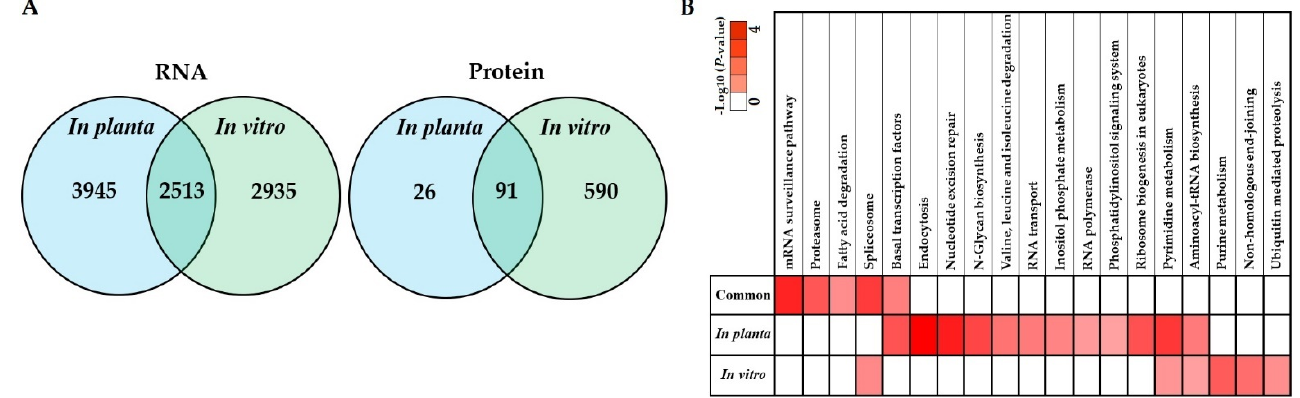
Figure S1: Correlation between RNA-seq and qPCR, Figure S2: Comparison of differently abundant transcripts from S. subterranea in resistant and susceptible potato cultivars, Table S1: List of primers used in this study, Table S2: RNA-seq information, Table S3: List of identified, annotated and differentially expressed transcripts, Table S4: List of identified and differentially expressed proteins, Table S5: List of common proteins in both RNA-seq and proteomics, Table S6: List of identified proteins in our transcriptome database.